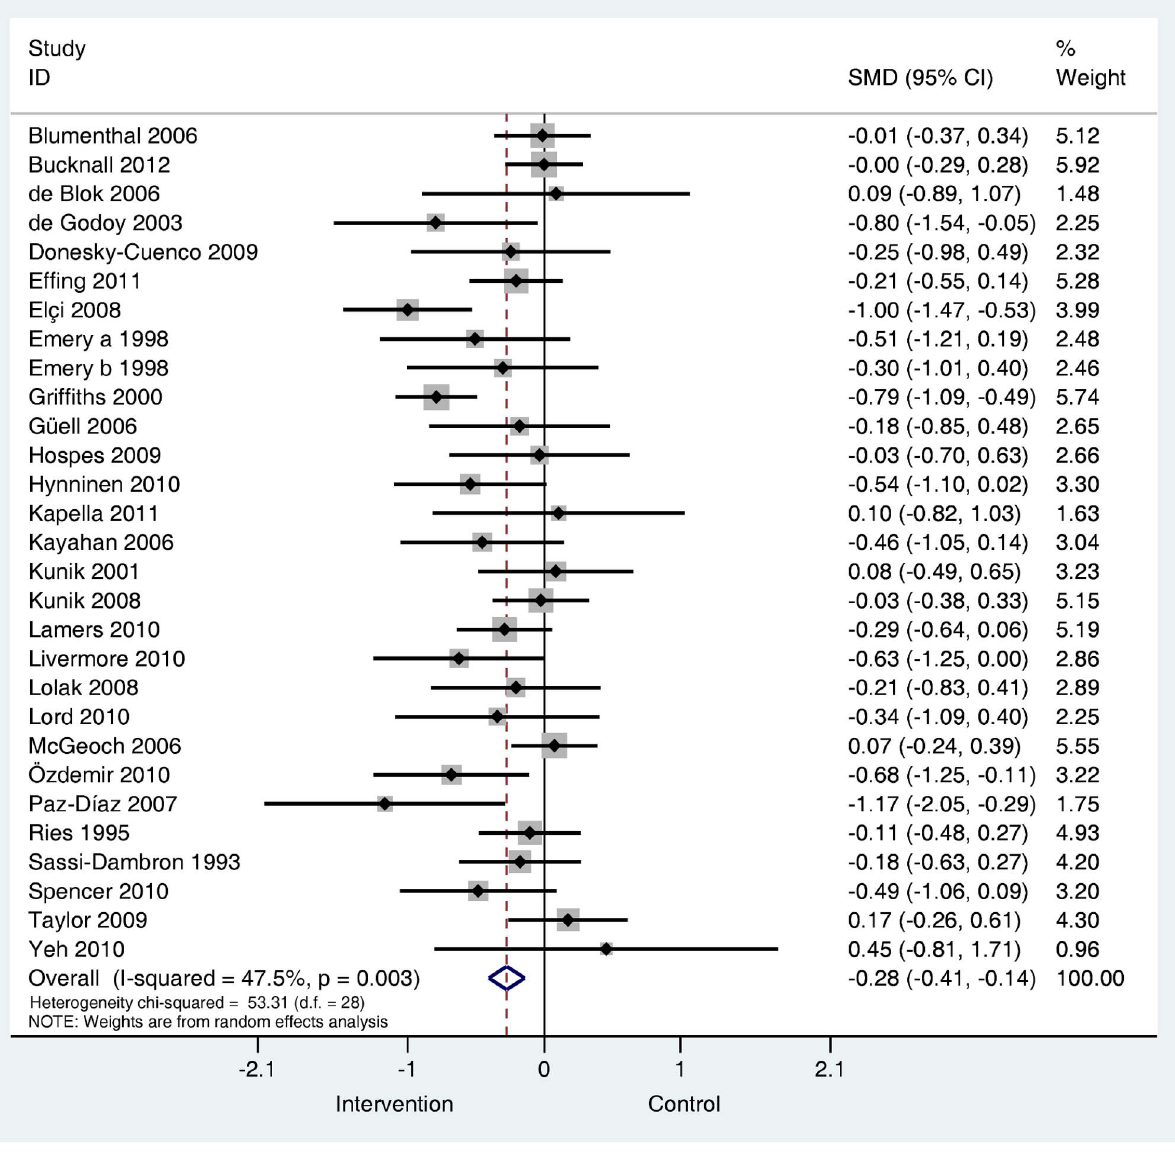
Figure 2. Effects of complex interventions on self-reported depression symptoms at post-treatment. Note: Meta-analysis of Individual trial and pooled effects. Random effects model used. 95% CI=95% confidence intervals; SMD=standardised mean difference.